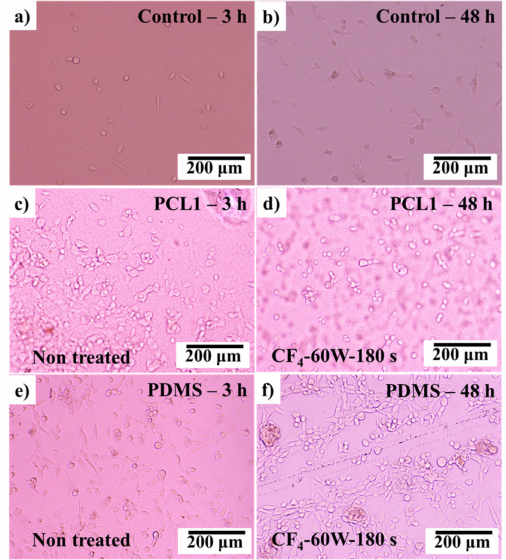
Figure 9. After 3 and 48 h of culturing fibroblast (3T3) cells on ( a , b ) control surface, ( c , d ) PCL1 surface treated with CF 4 , and ( e , f ) PDMS surface treated with CF 4